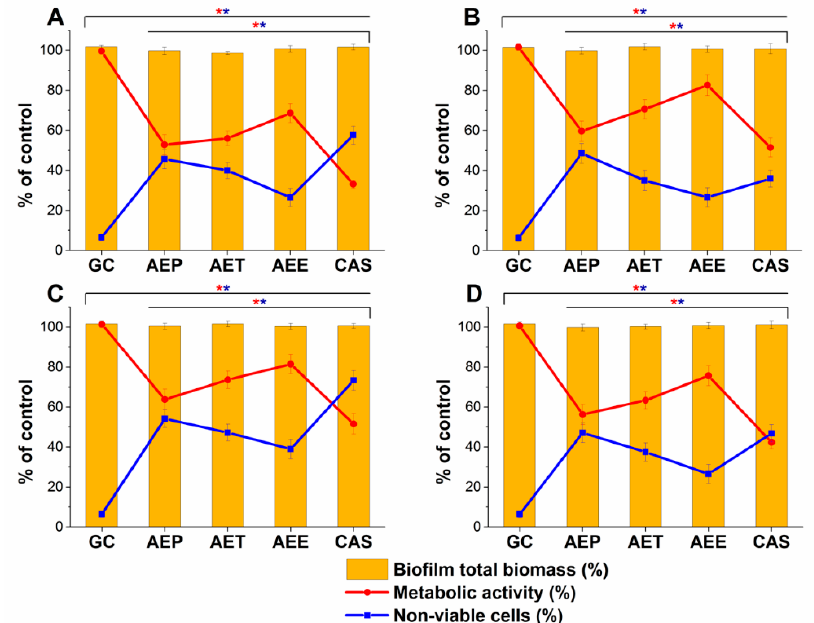
Figure 17. Effects of AEP, AET and AEE after 24 h of treatments at their respective MEC 10 concentrations on the metabolic activity, amount of biofilm biomass, and viability of C. albicans ( A ), C. tropicalis ( B ), C. dubliniensis ( C ) and C. krusei ( D ) cell populations (mean ± SD, n = 6 independent experiments each with three technical replicates, data were compared with untreated controls (GC) and with caspofungin (CAS)-treated positive controls. The red ( * ) and blue ( * ) asterisks represent a significance value of P < 0.01 for the metabolic activity and viability measurements, respectively.